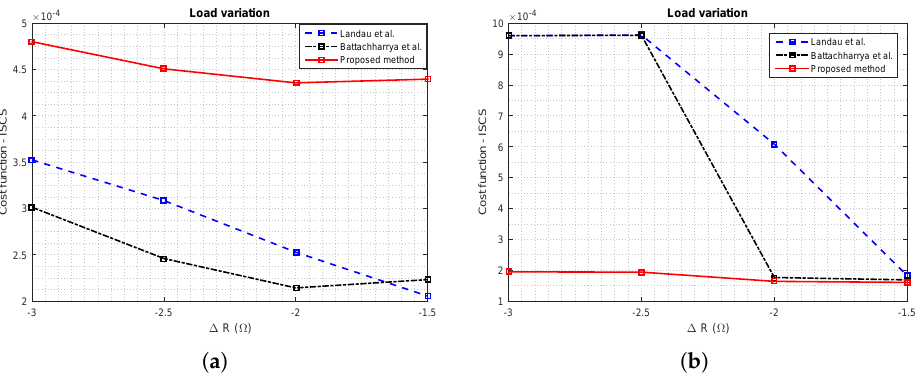
Figure 21. Cost function ISC when occurs the load variation. ( a ) Simulation and ( b ) Experimental